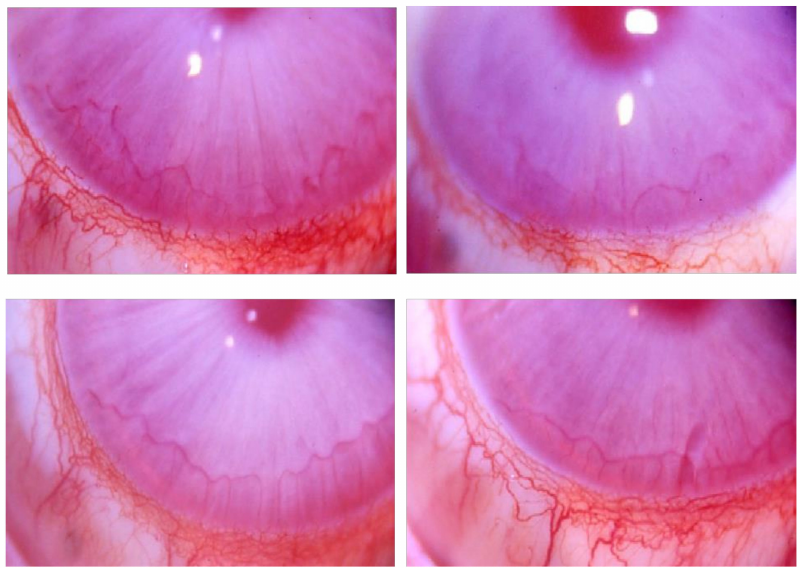
Figure 5. Images of implanted rabbit corneas. The ready to use solution of Bioexpander ® was surgically injected in the cornea stroma of albino NZW rabbits under anaesthesia. In the following 2 weeks, corneas remained transparent and no angiogenesis occurred (n = 4). The pictures were taken at day 10. The white spots are reflex